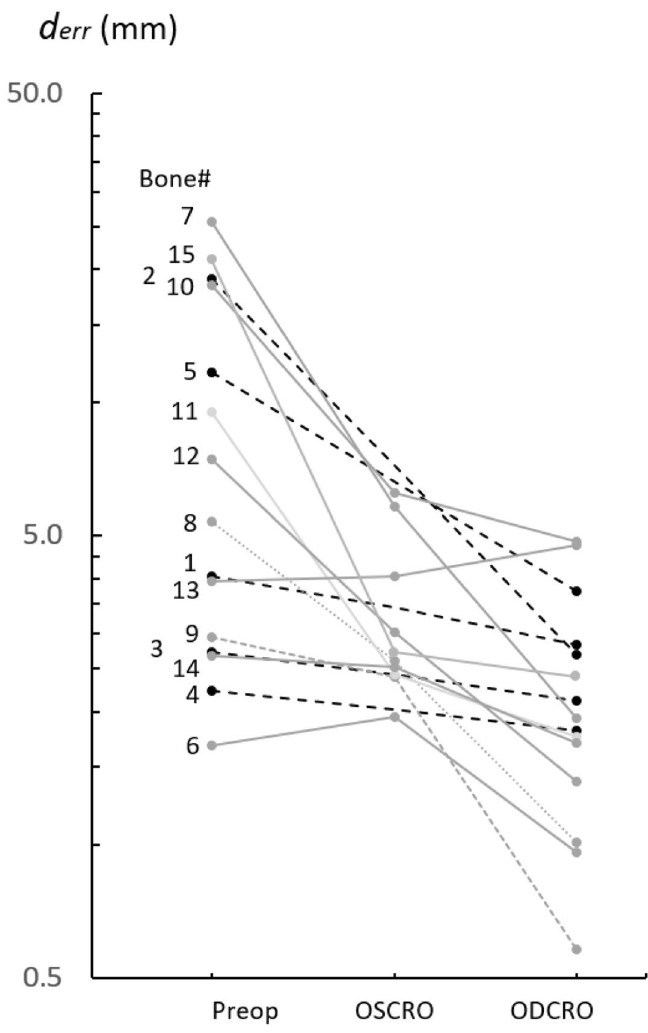
Figure 9. Malalignment before treatment (Preop), and after treatment using an oblique single-cut rotation osteotomy (OSCRO) or oblique double-cut rotation osteotomy (ODCRO), expressed in terms of the average distance ( d err ) of each point in the bone mesh (affected, corrected by OSCRO, corrected by ODCRO) to the nearest point in the target bone. Each line connects results for a bone case as shown in Figs. 7 and 8. The dotted lines represent cases that were not eligible for treatment by an OSCRO because of a very steep